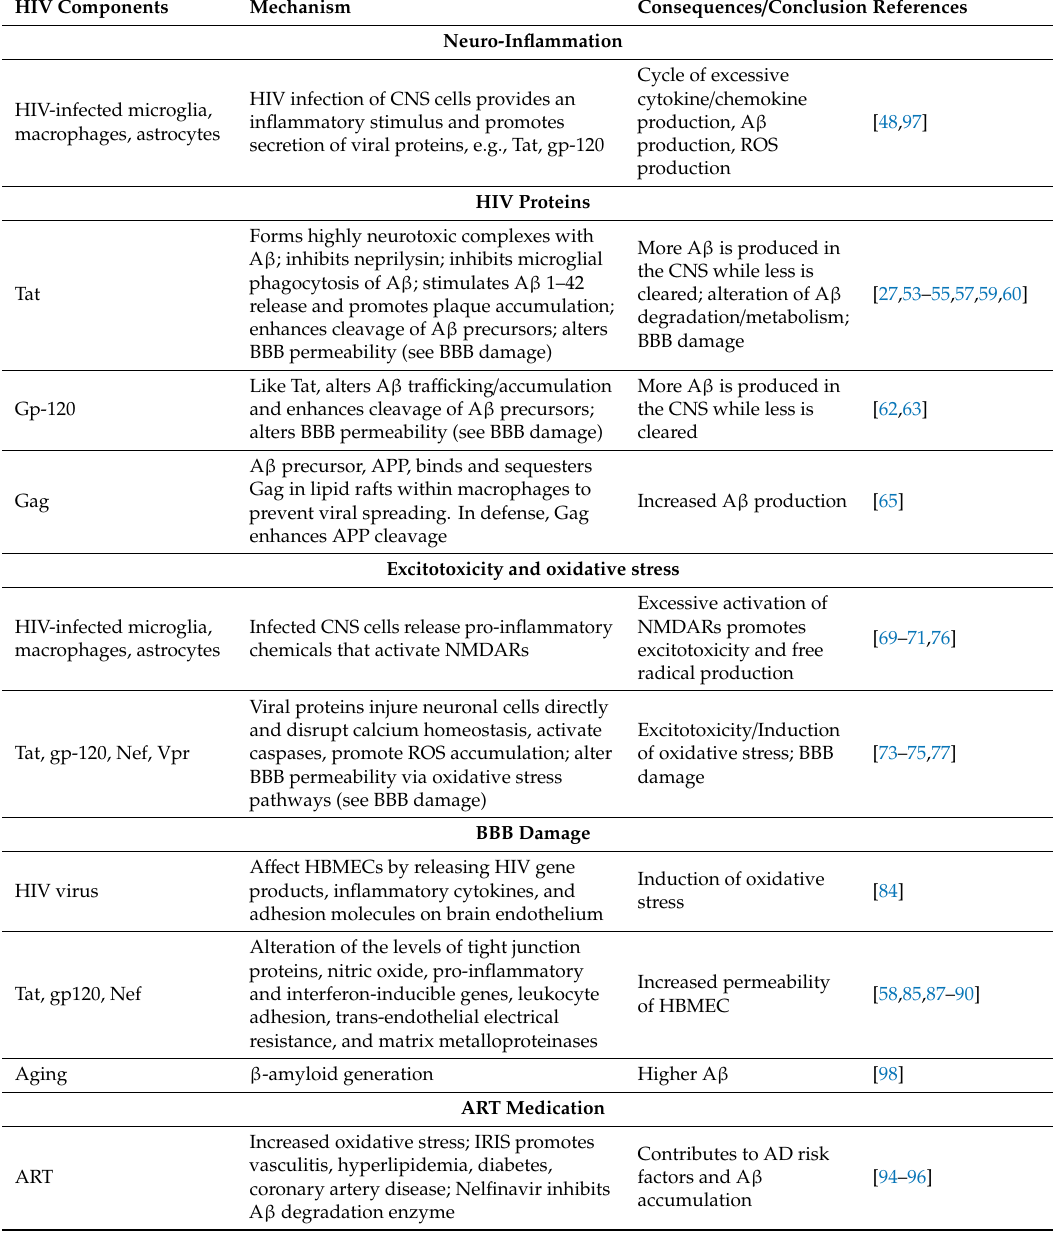
Table 1. Summary of HIV-induced mechanisms contributing to neurodegeneration / AD-like pathology. HIV